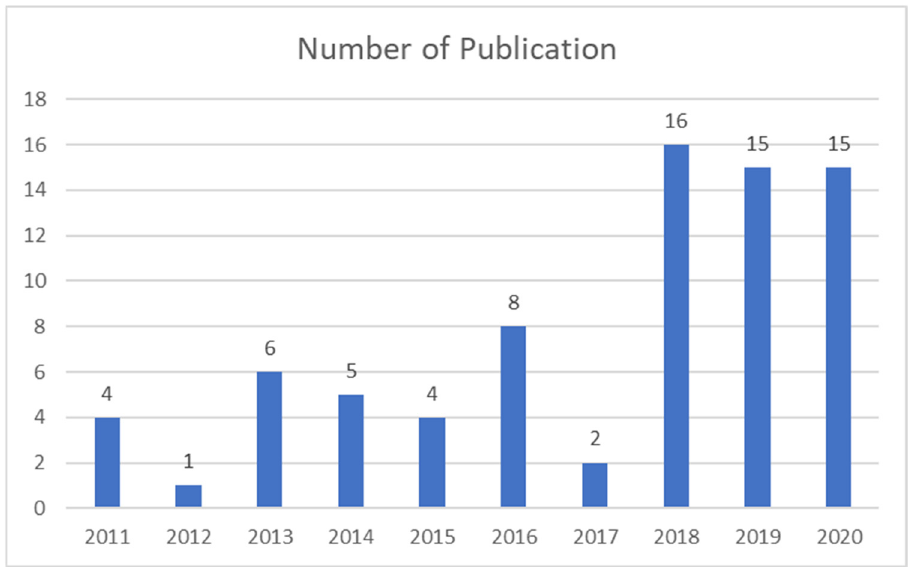
Figure 2. The number of publication trends from 2011–2020.